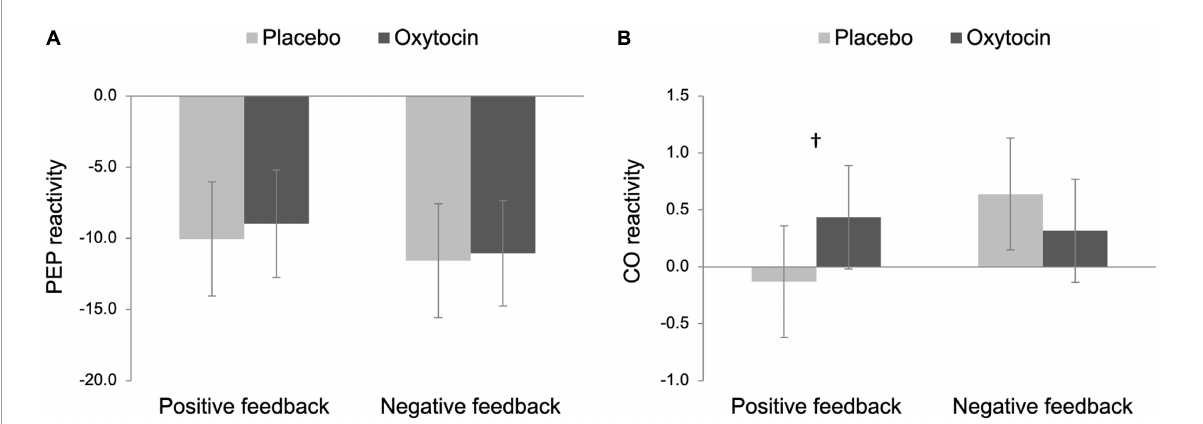
FIGURE2 Pre-ejection period (PEP; A ) and cardiac output (CO; B ) reactivity as a function of intranasal spray (placebo vs. oxytocin) in each feedback condition. Lower scores on PEP reactivity indicate greater sympathetic nervous system (SNS) activation while higher scores on CO reactivity indicate greater cardiac efficiency. Challenge patterns of cardiovascular reactivity are characterized by an increase in SNS activity along with an increase in cardiac efficiency whereas threat patterns of cardiovascular reactivity are characterized by an increase in SNS along with no change in cardiac efficiency. Error bars indicate 95% confidence intervals. † p <